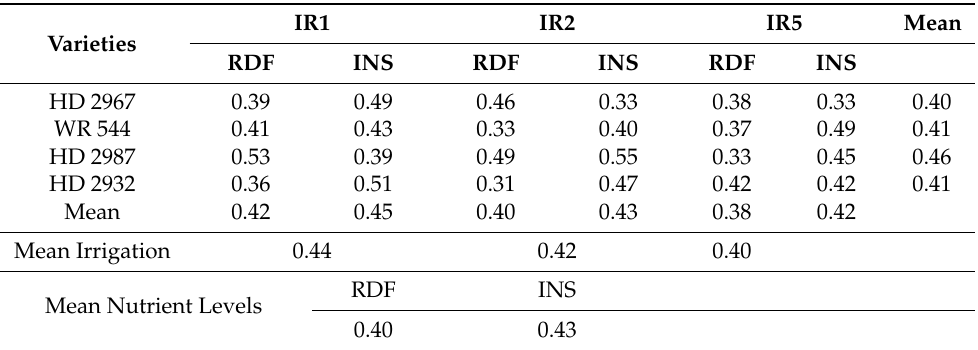
Table 8. Interaction effect of nutrient management levels, irrigation schedules, and varieties on soil organic carbon